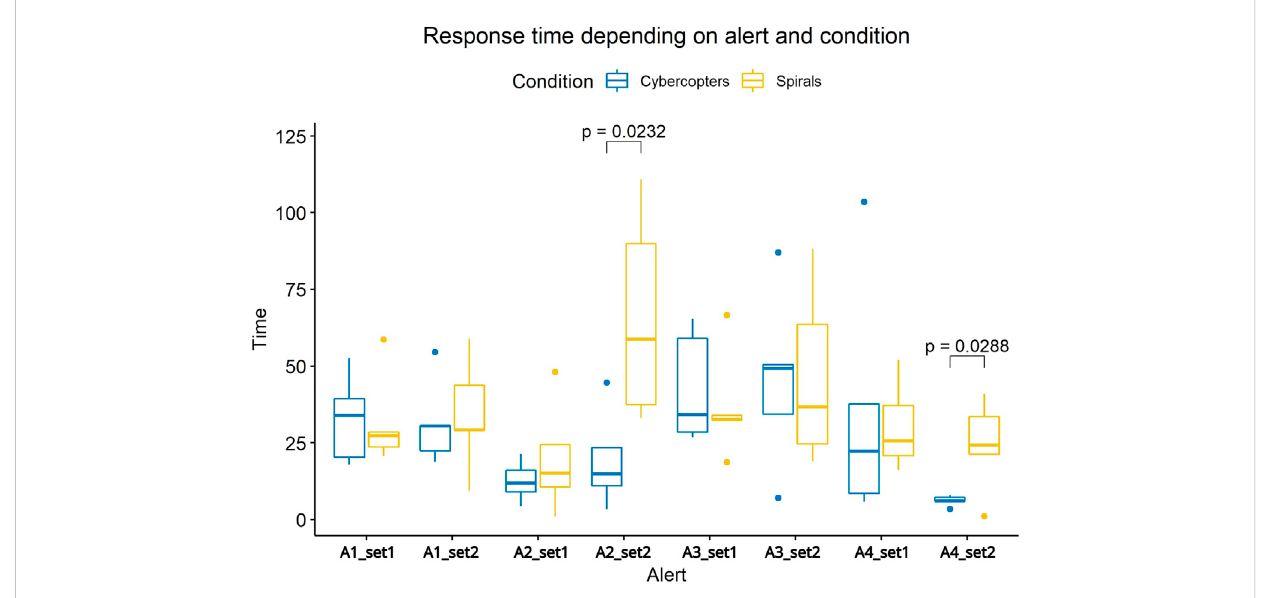
FIGURE 8 Response time to each alert depending on the set and interface. The response times to alerts 2 and 4 of set 2 are signi fi cantly different between the two interfaces.